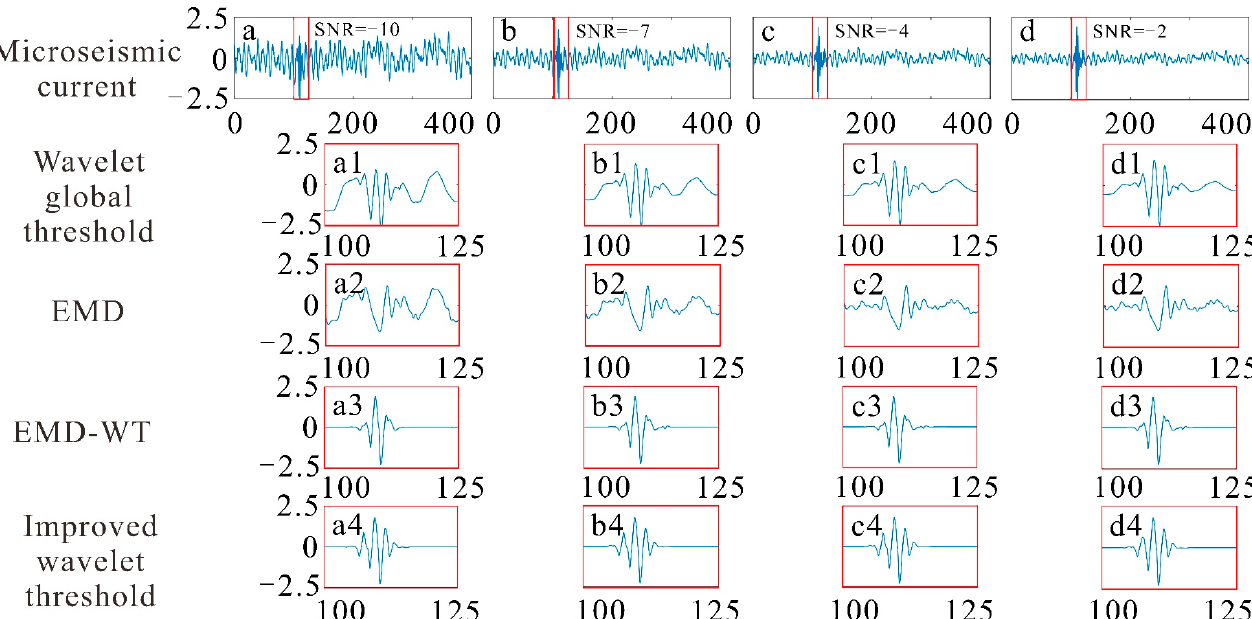
Figure 8. Comparison of denoised synthesized microseismic signals with different SNRs: ( a ) micro- seismic noise of SNR = − 10, ( b ) microseismic noise of SNR = − 7, ( c ) microseismic noise of SNR = − 4, ( d ) microseismic noise of SNR = − 2, ( a1 , b1 , c1 , d1 ) Wavelet global threshold denoising signal, ( a2 , b2 , c2 , d2 ) EMD denoising signal, ( a3 , b3 , c3 , d3 ) EMD-WT denoising signal, ( a4 , b4 , c4 , d4 ) im- proved wavelet threshold denoising signal.